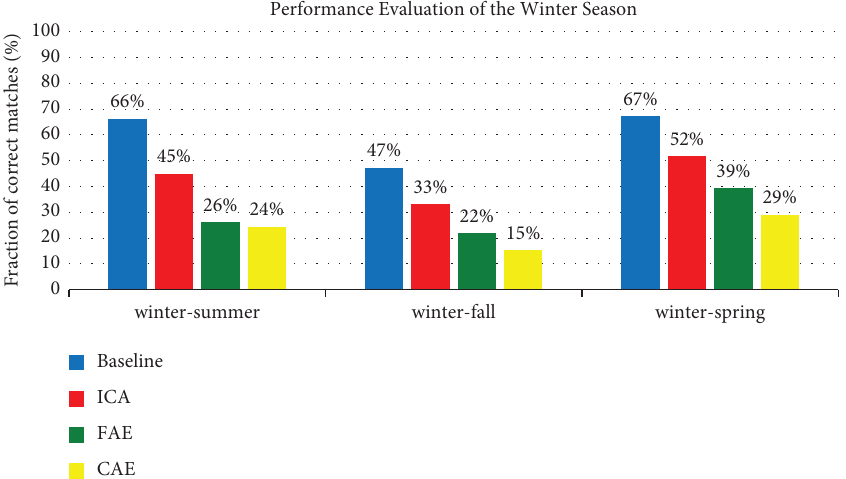
Figure 17: Fraction of correct matches of the baseline and proposed algorithms on the winter season